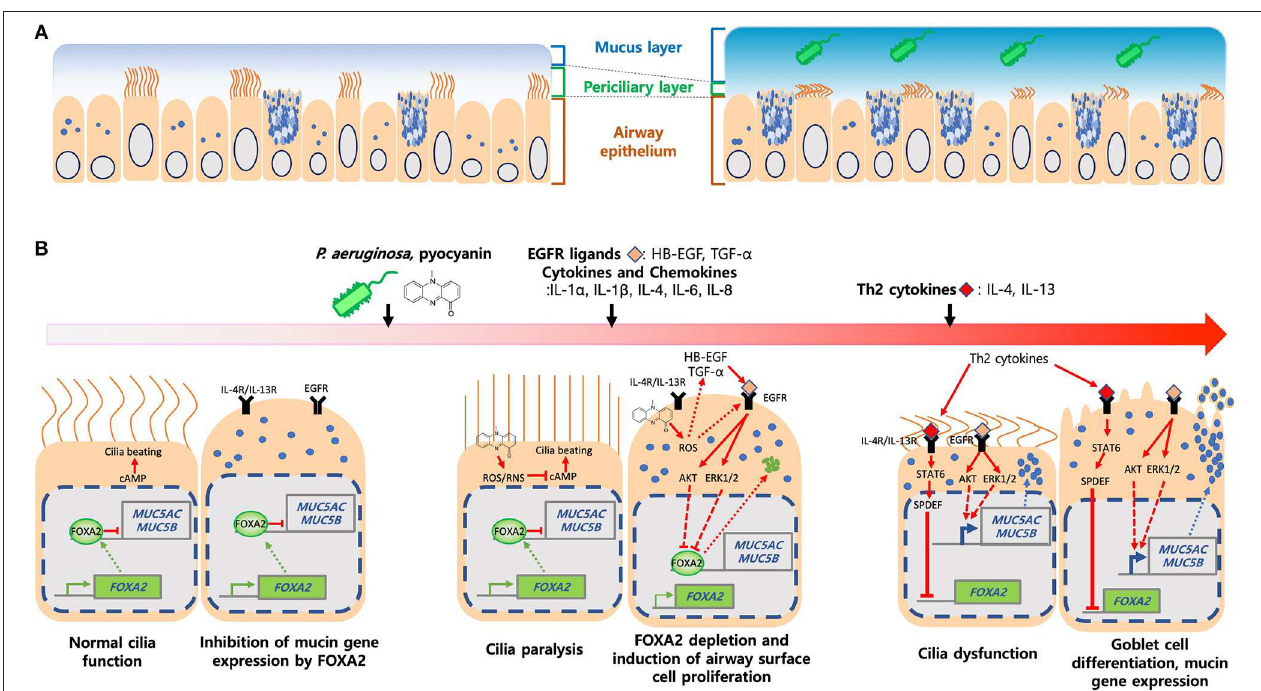
FIGURE 2 | Induction of mucus hypersecretion by P. aeruginosa pyocyanin. (A) Composition of mucus layers in heathy and diseased airways. (B) P. aeruginosa and its virulence factors, especially pyocyanin, stimulate excessive ROS, chemokines and cytokines and, ligands that activate IL-4R/IL-13R-STAT6-SPDEF, and EGFR-AKT/ERK1/2-mediated signaling pathways. Both kinase cascades converged to inhibit FOXA2, resulting in over proliferation and differentiation of airway epithelial (ciliated and club) cells to mucus-secreting goblet cells. Excessive mucus and failure in the clearance exacerbates airway obstruction and microbial colonization and